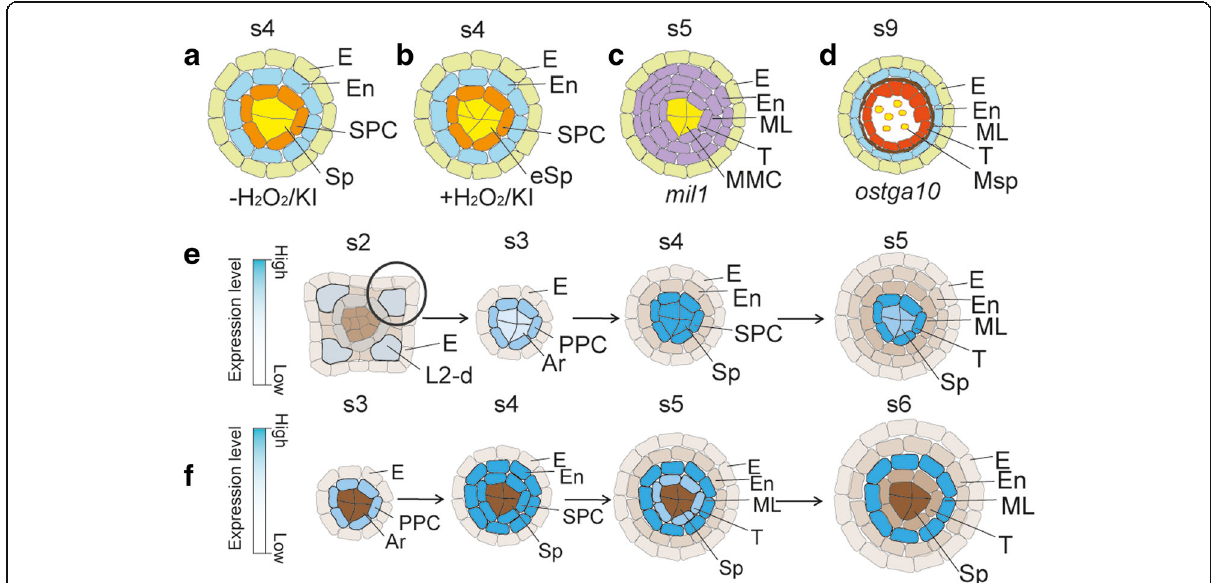
Fig. 2 GRXs and TGAs are important for anther development. a Wild-type anther with normal number of Sp cells at stage 4, b Wild-type anthers treated with H 2 O 2 or KI with excess Sp cells at stage 4, c Phenotype of mil1 anther at stage 5, d Phenotype of ostga10 anther at stage 9, e Expression pattern of MIL1 in anther, f Expression pattern of OsTGA10 in anther. Purple color in c shows abnormal somatic cell layers; blue color in e and f shows the gradient of gene expression; grey color in e and f shows different cell layers without the expression of MIL1 ( e ) or OsTGA10 ( f